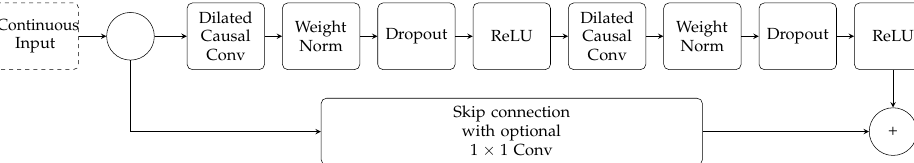
Figure 4. Residual block of the